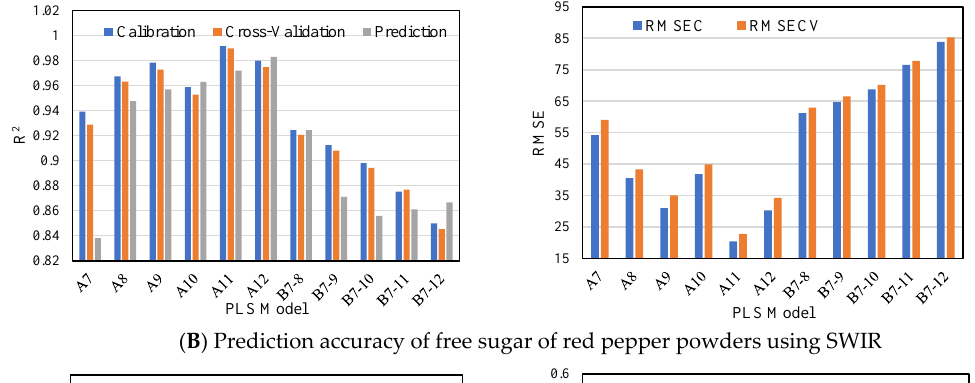
( B ) Prediction accuracy of free sugar of red pepper powders using SWIR